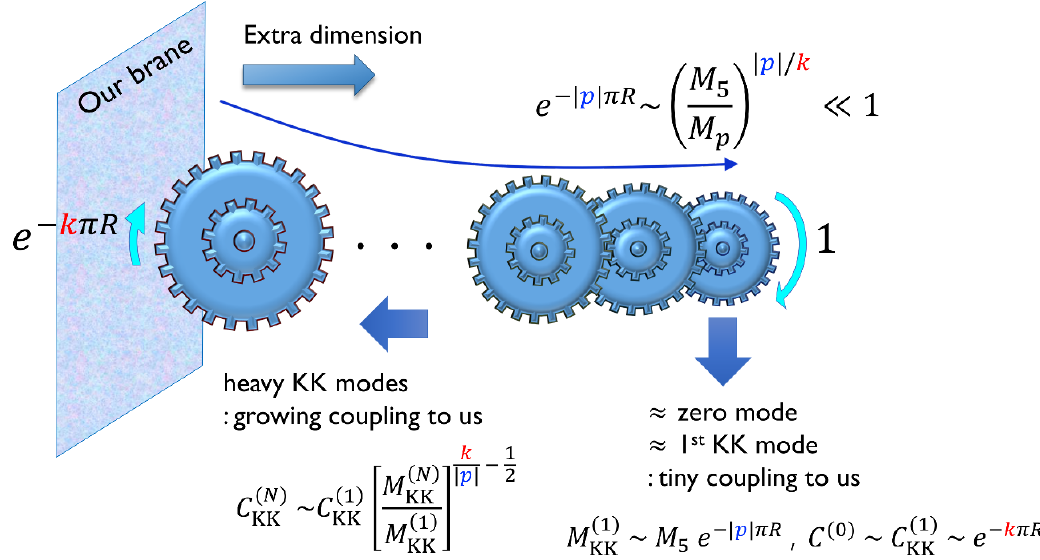
Figure 2 . The KK structure for ^ c 2 >